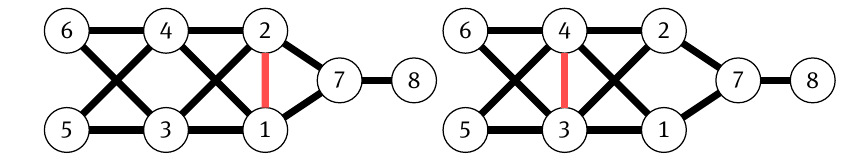
cospectral construction is described for the distance Laplacian using co-transmission twins. If a graph G has